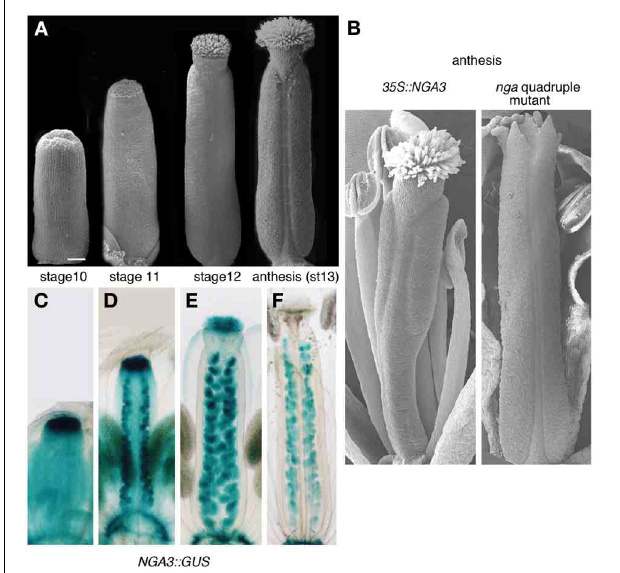
FIGURE 1 | Gynoecium development in Arabidopsis and NGA-related mutants. (A) Scanning electron micrographs of wildtype gynoecia at different stages of development. (B) Phenotypes at anthesis of 35S::NGA3 (left) and nga quadruple mutant pistils (right). (C–F) Expression of NGA3 in gynoecia at the same stages shown in (A) , revealed by the histochemical activity of a GUS reporter gene directed by NGA3 regulatory sequences (Trigueros et al.,